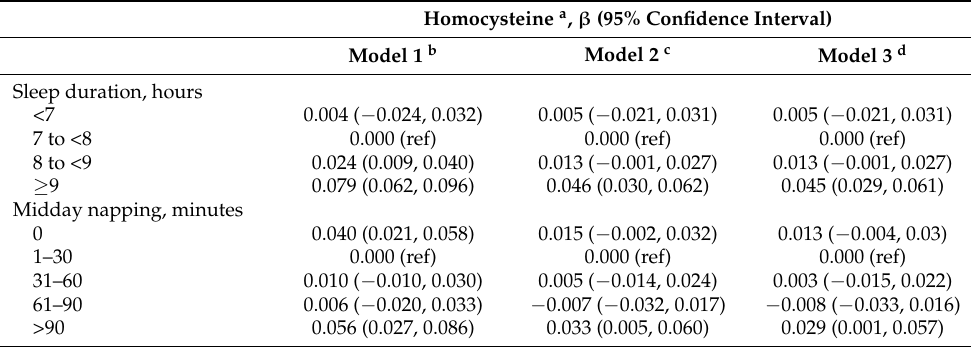
Table 3. Association of sleep duration and midday napping with serum homocysteine levels. Homocysteine a , β (95% Confidence